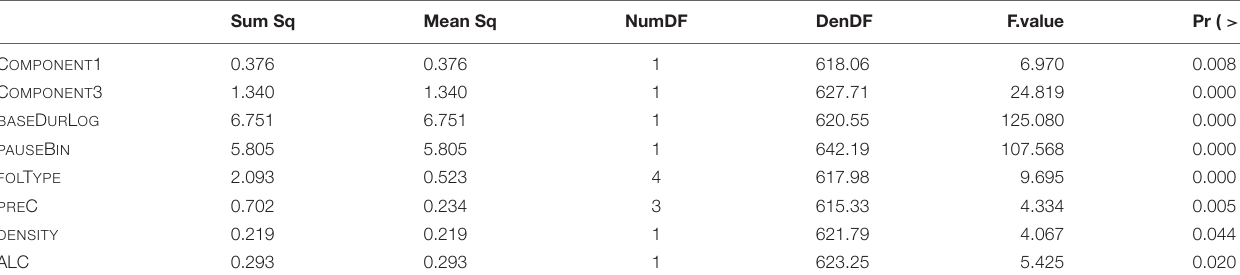
TABLE 6 | p -values of fixed effects in the final “LDL measures and Affix” model, fitted to the log-transformed durations of S. Sum Sq Mean Sq NumDF DenDF F.value